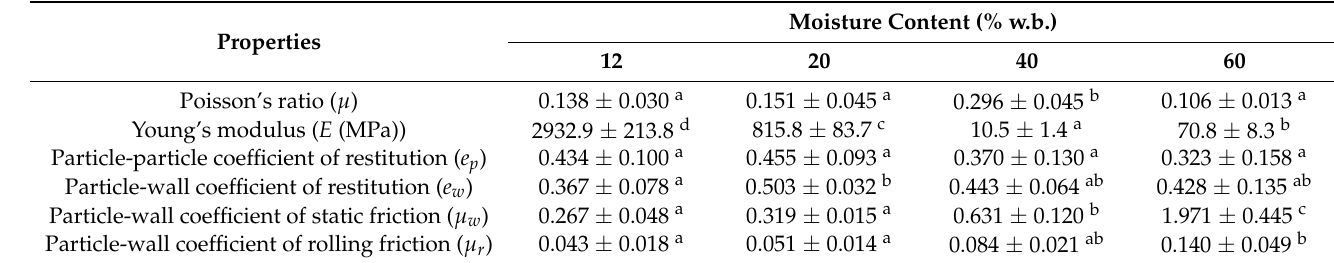
Table 2. Physical properties of the soybean grains with various moisture